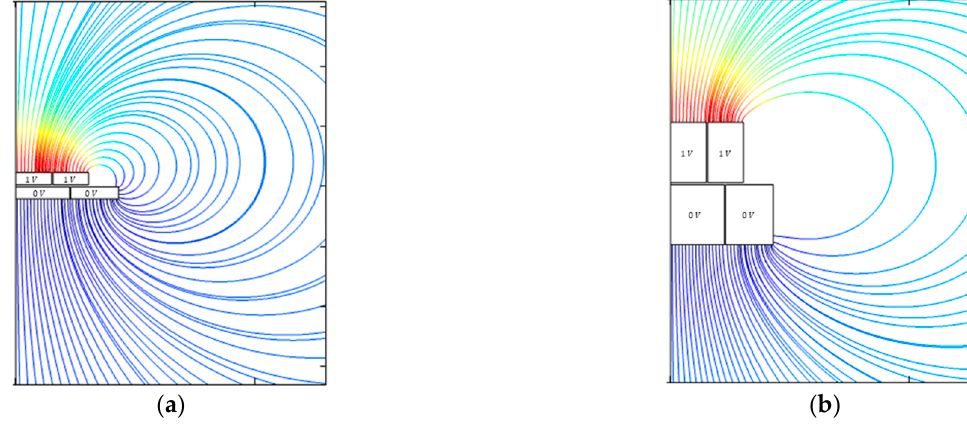
Figure 16. Propagation of the electric field lines outside the capacitor for ( a ) thin electrodes and ( b ) thick electrodes. The thicker the electrodes, the more field lines propagate into the electric far field in a less disturbed manner, and the smaller the top stray capacitance becomes.